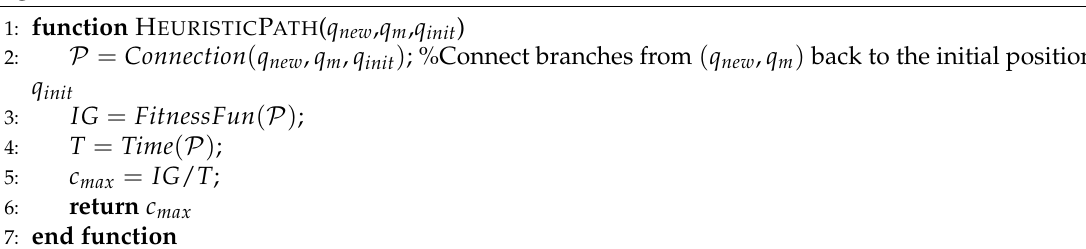
Algorithm 7 Heuristic Path